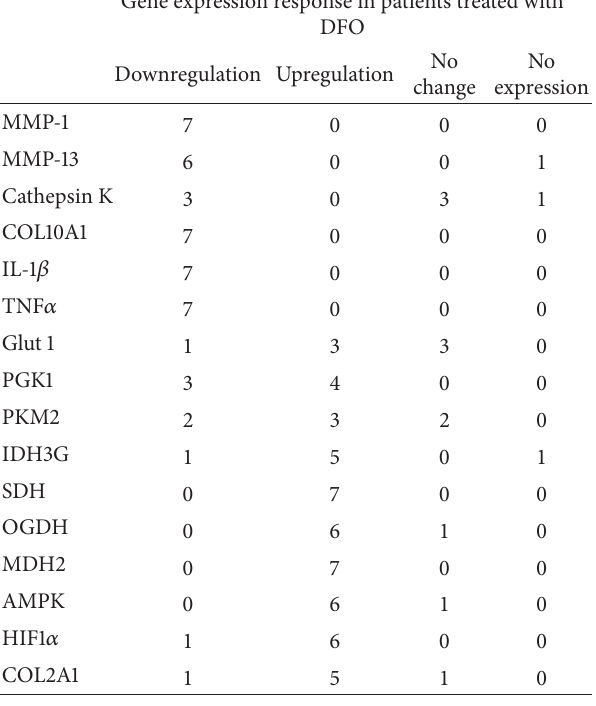
Table 1: Summary of gene expression in OA articular cartilage